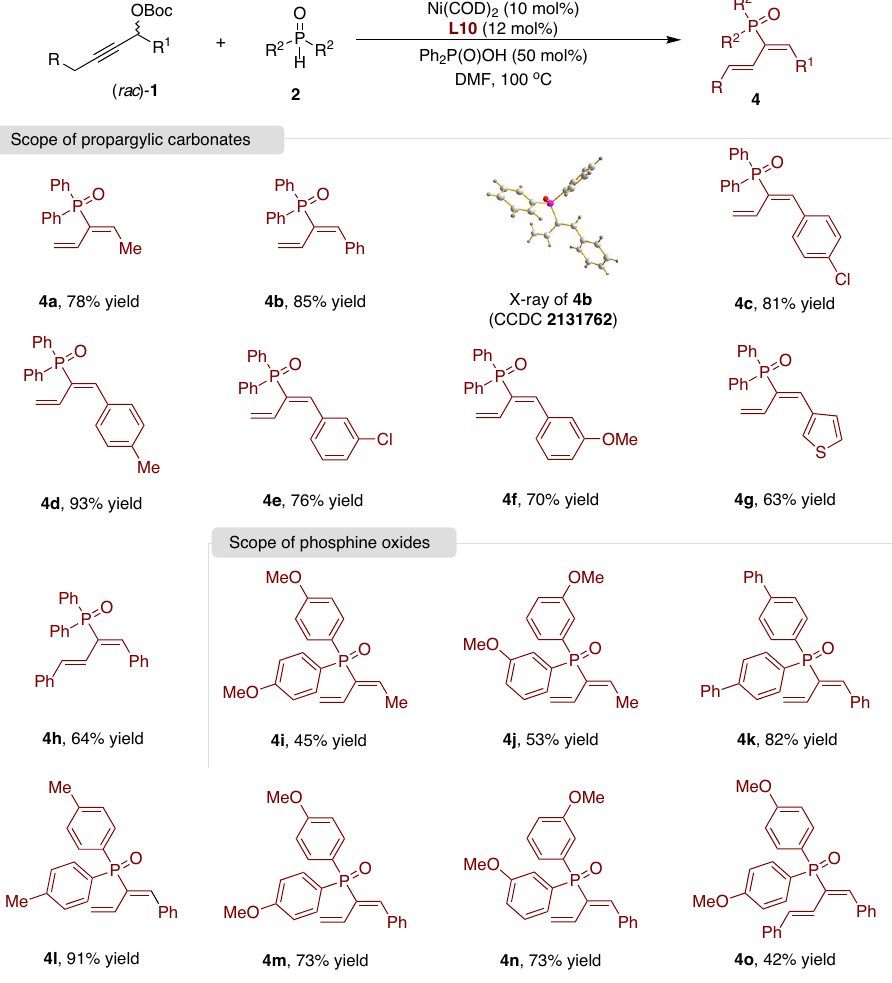
Fig.4 |Nickel-catalyzed1,3-dienylation ofphosphineoxides. Reactionswereconducted byusingNi(COD) 2 (10mol%), L10 (12mol%),( rac )- 1 (0.12mmol), 2 (0.1mmol), and Ph 2 P(O)OH (50mol%) in DMF at 100°C. Isolated yields after chromatography are